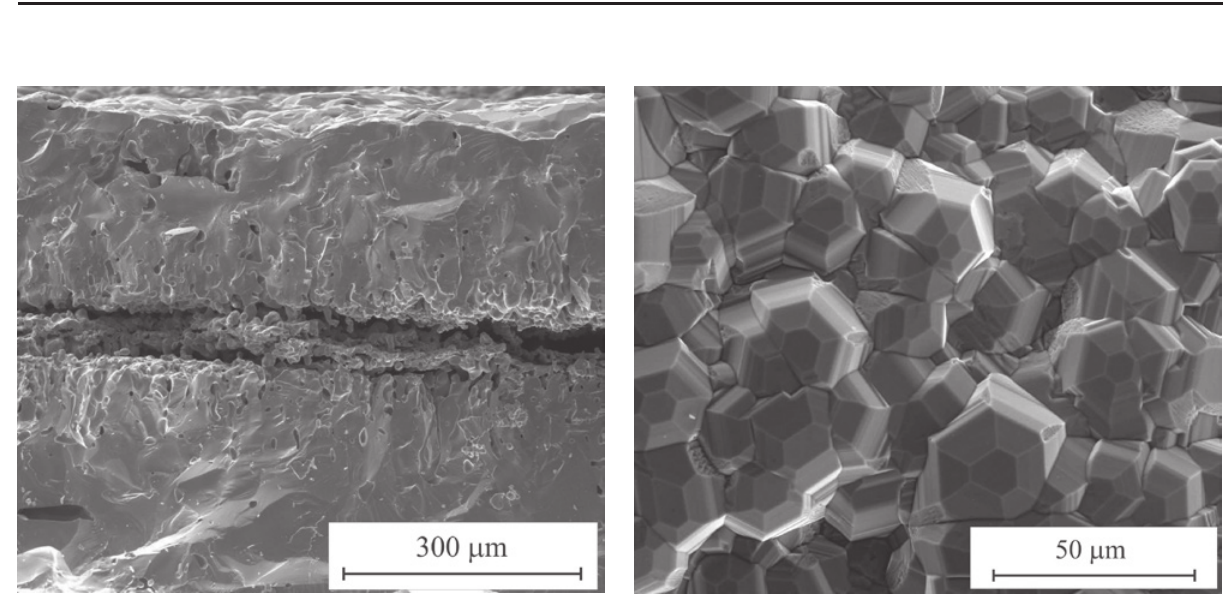
Fig. 2: Cross-section of NiS sulphide formed after complete sulphidation of flat Ni sample at 873 K and sulphur vapor pressure equal 100 Pa.